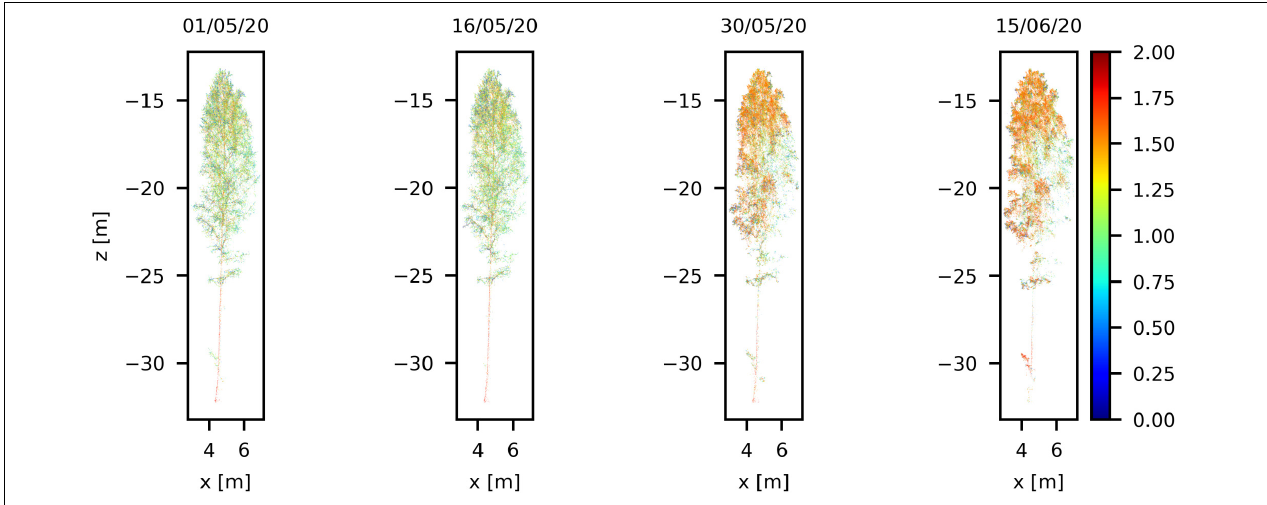
FIGURE 5 | Seasonal variation in a Silver birch crown during the spring growth season visualized with four scans between May and June in 2020. The color scale presents individual laser point reflectance in logarithmic scale (0–2.0).